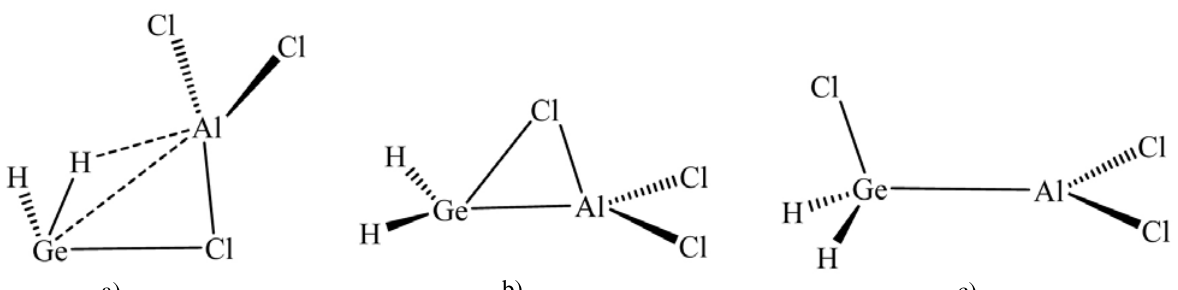
Figure 1. The equilibrium configurations of the germylenoid H